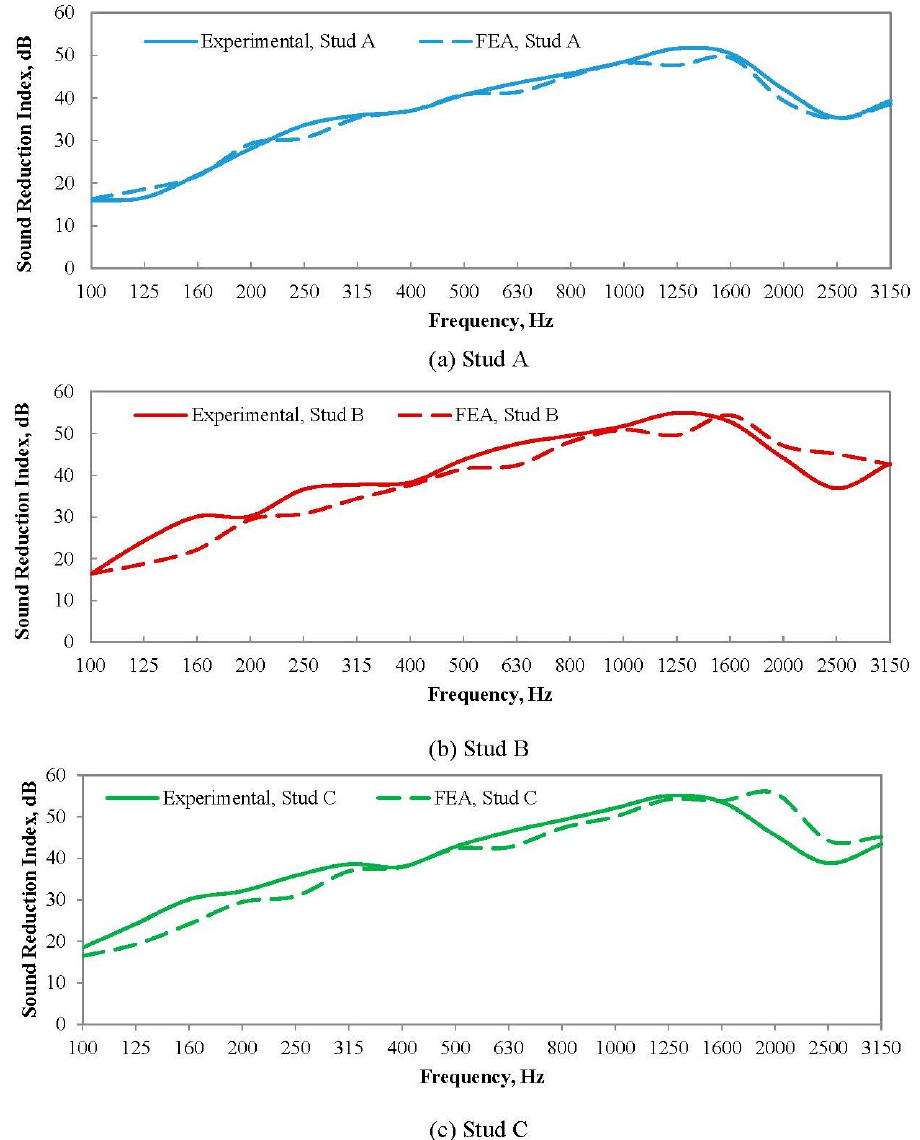
Figure 13. Comparison of R values using FEA and experimental tests for ( a ) Stud A; ( b ) Stud B; and ( c ) Stud